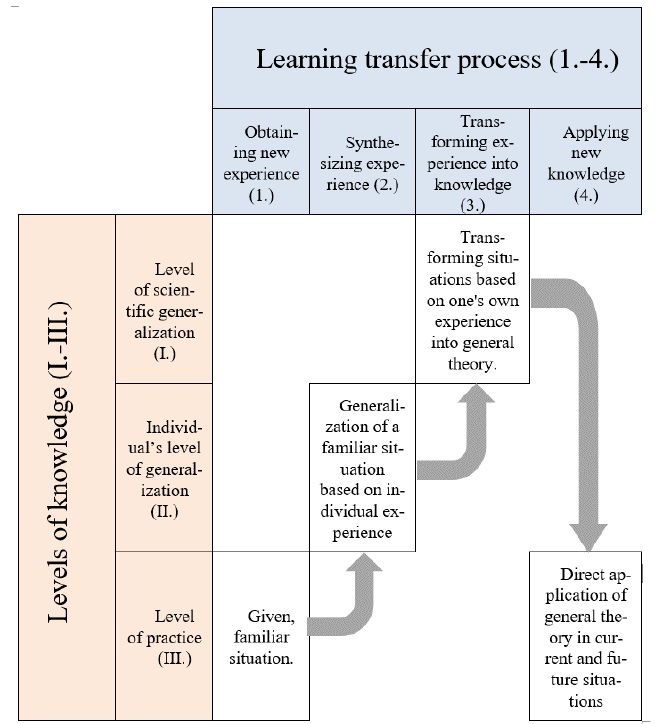
Fig. 2. The learning transfer process used to introduce a portfolio based on